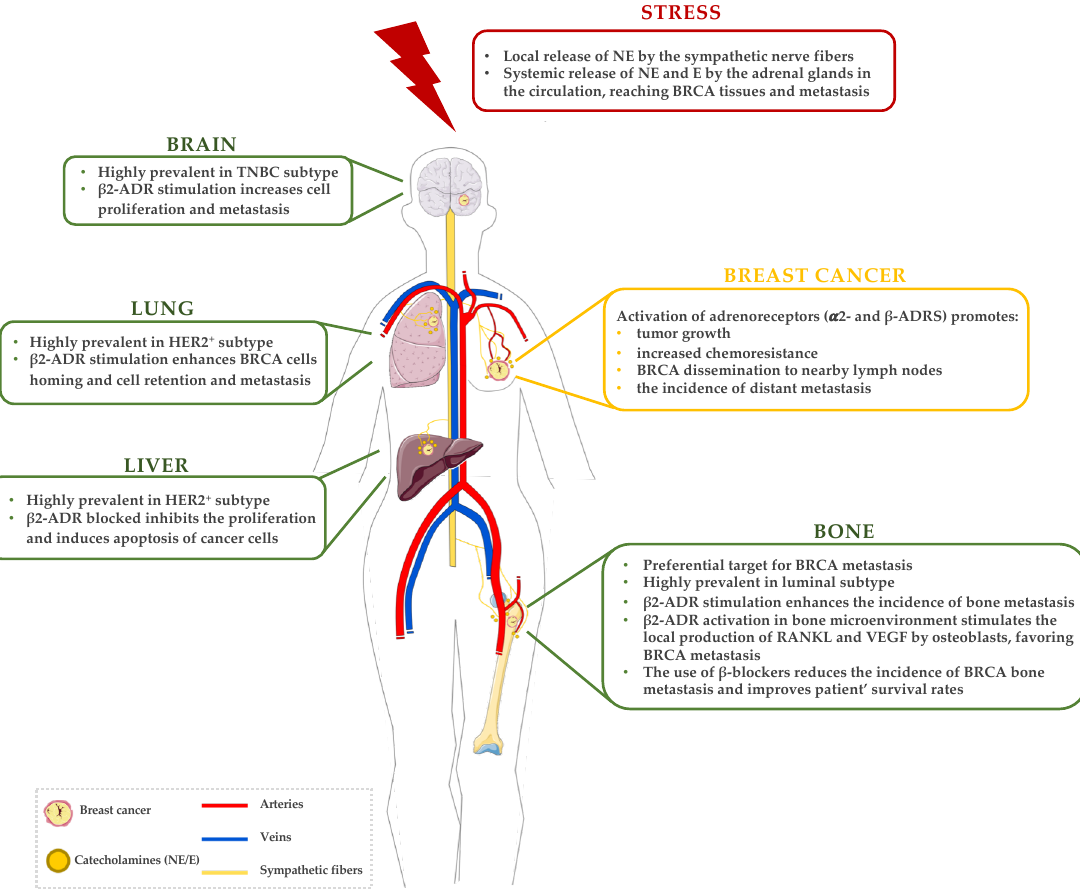
Figure 2. A brief summary of the established correlations between stress, BRCA and metastases. In a stress situation, catecholamines (NE and E) are released by the sympathetic fibres and sympathoad- renal system. These catecholamines stimulate the activation of adrenergic receptors, locally in BRCA primary tissue and also by affecting the BRCA metastatic organs. Abbreviations: ADR—adrenergic receptor; BRCA—breast cancer; E—epinephrine; HER2—human epidermal growth factor 2; NE— norepinephrine; RANKL—receptor activator of NF- κ B ligand; TNBC—triple-negative breast cancer; VEGF—vascular endothelial growth